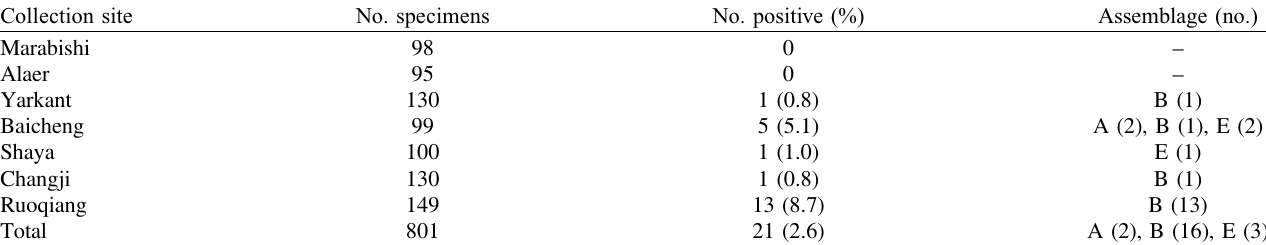
Table 2. The prevalence and assemblages of Giardia duodenalis in pigs from the seven large-scale farms in Xinjiang, China. Collection site